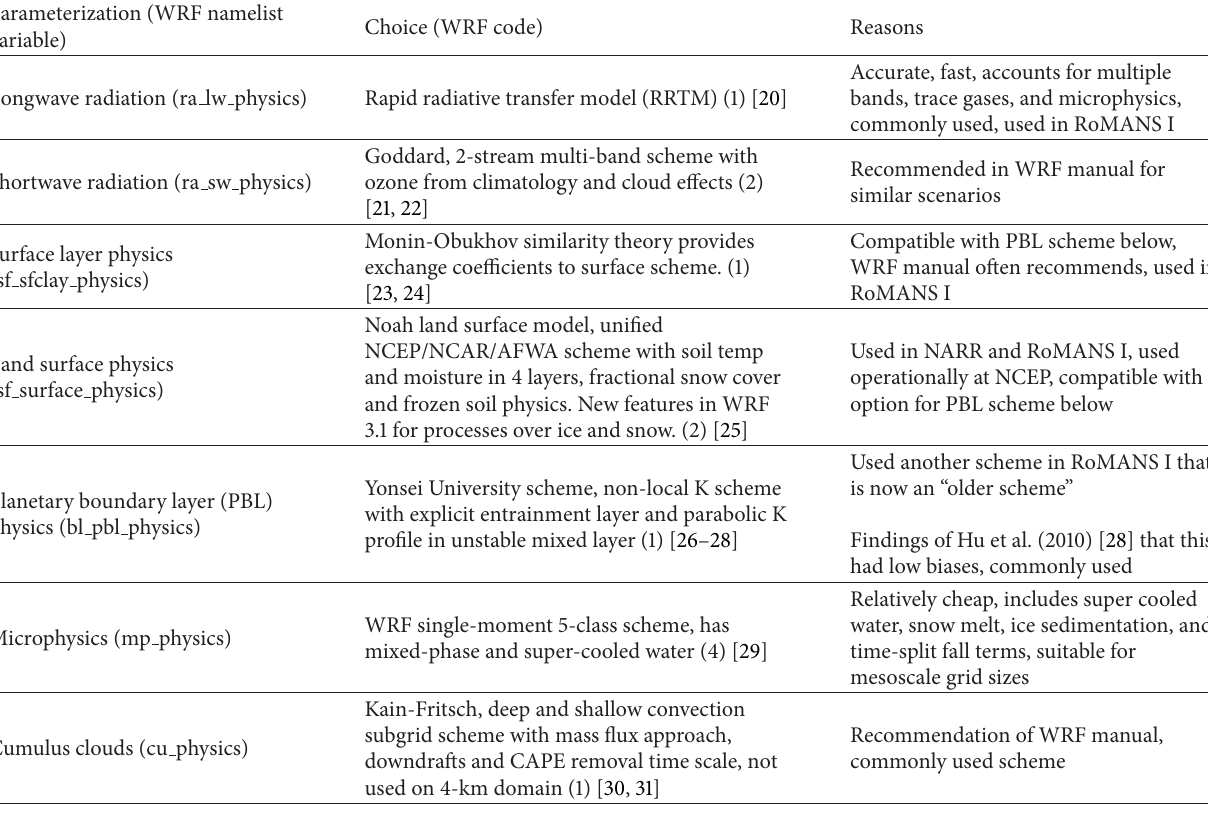
Table 1: Major physics choices for most WRF model runs, plus reasons. The values in parentheses are the WRF option names in column 1 and the WRF codes for the chosen options in column 2.